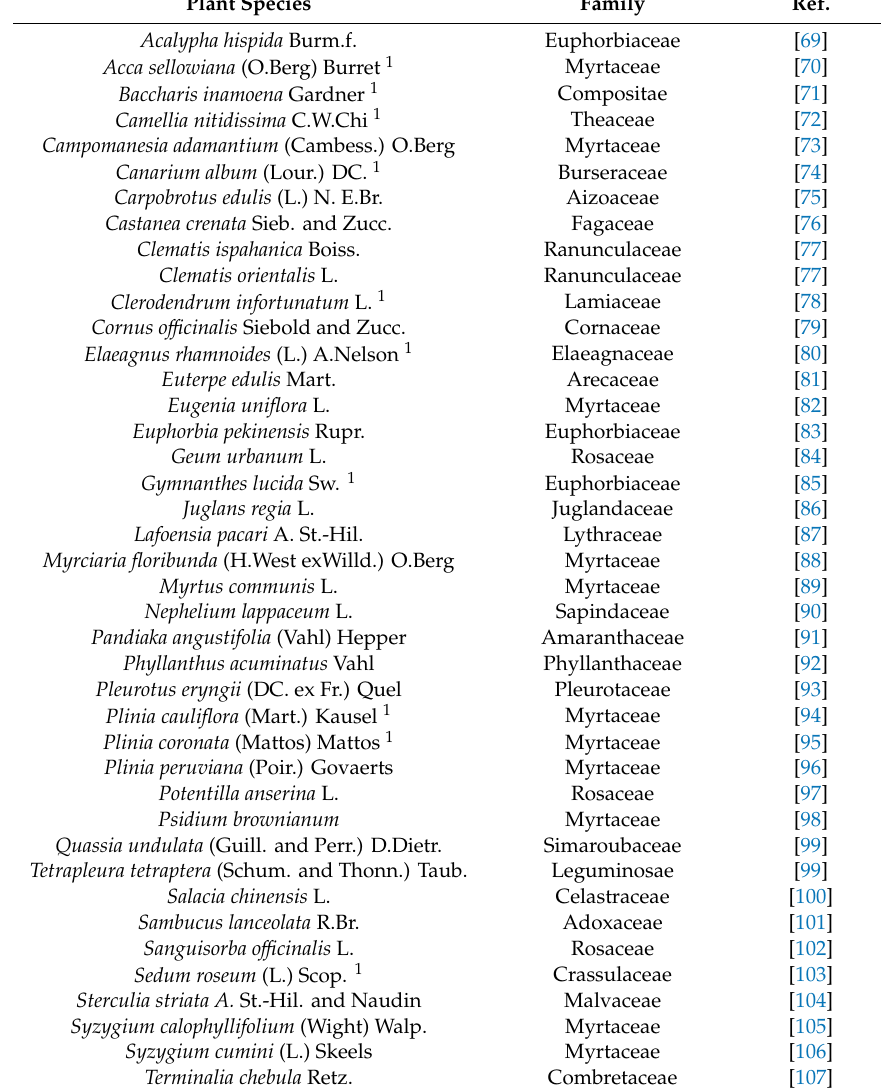
Table 7. Presence of ellagic acid in several medicinal